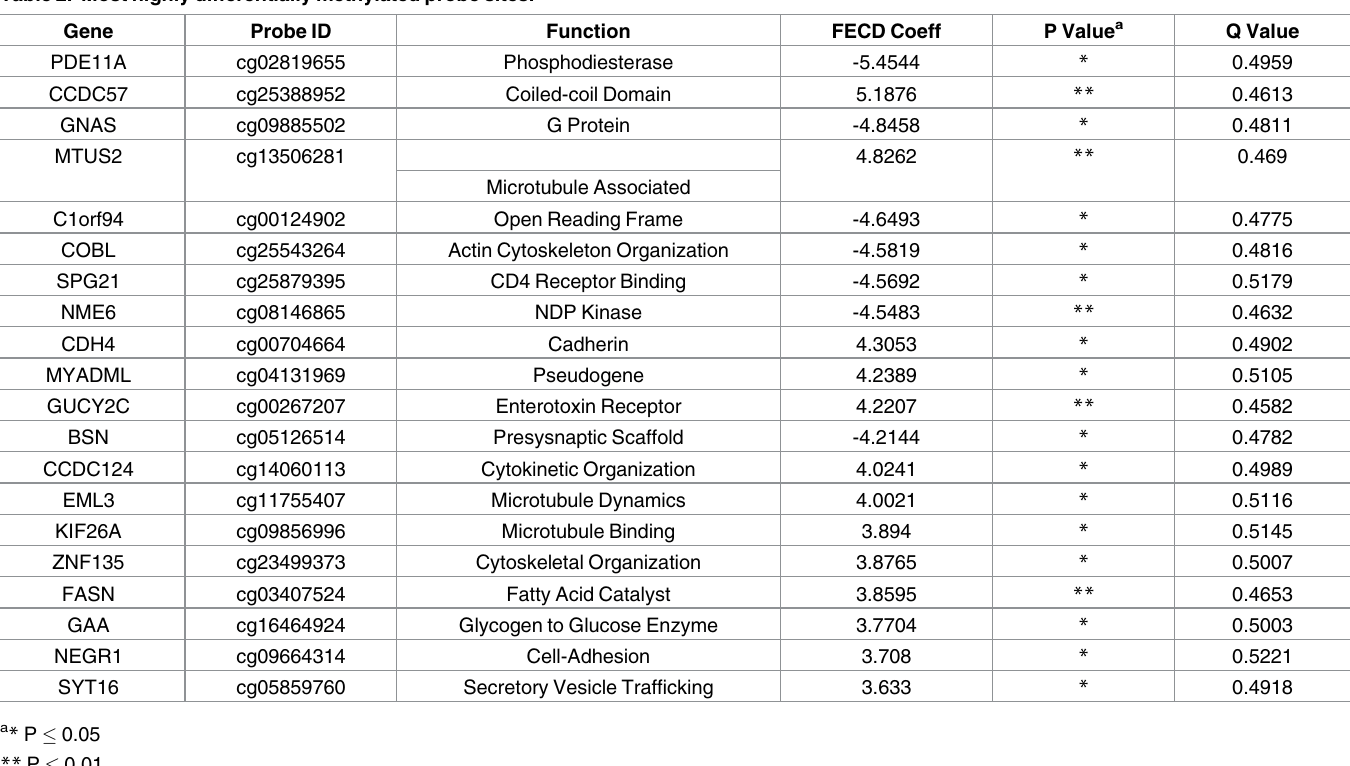
Table 2. Most highly differentially methylated probe